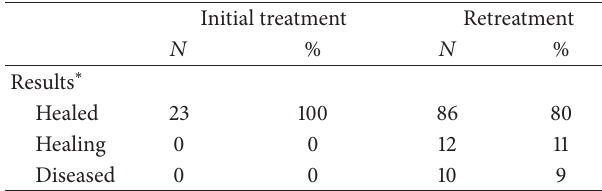
Table 2: Results. Table 3: Analysis of preoperative